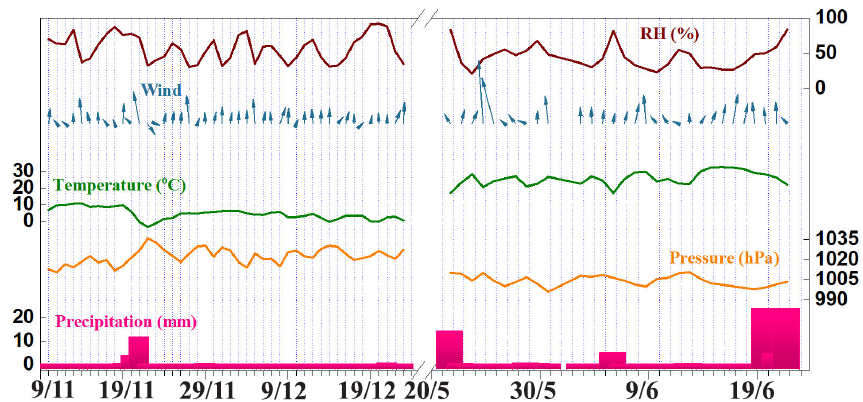
Figure 2. Daily variations in relative humidity (RH), wind direction (WD), temperature ( T ), pressure ( P ), and precipitation (Precip); data were obtained from the automatic meteorological stations at the sampling